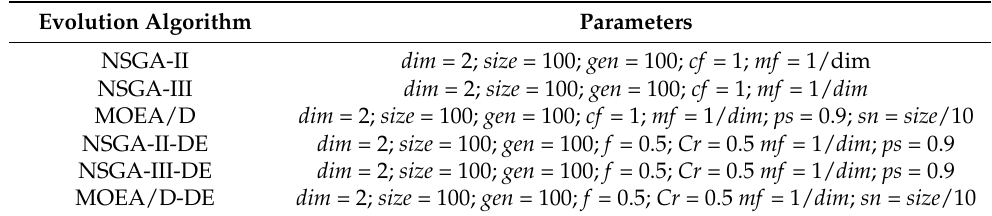
Table 2. The parameters of six evolution algorithms. Evolution